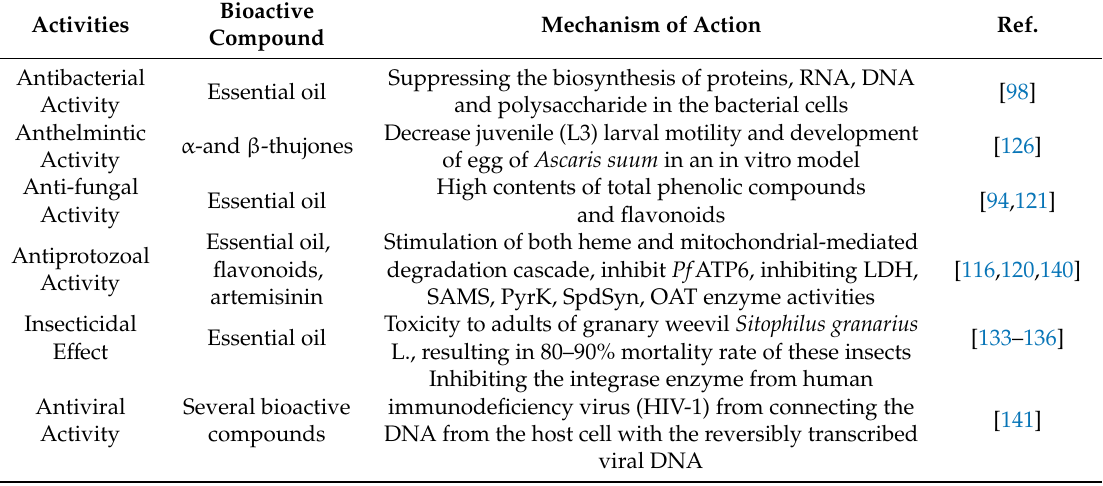
Table 5. The pharmacological activity of A. absinthium related to infectious